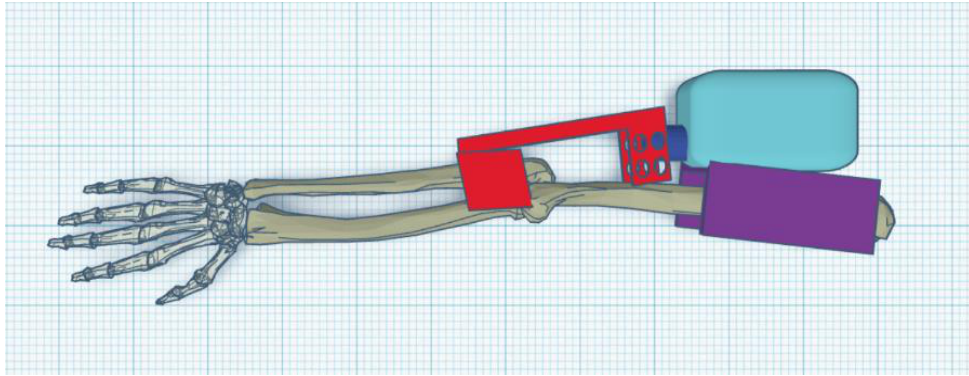
Figure 9. Upright exoskeleton with arm (0 ).